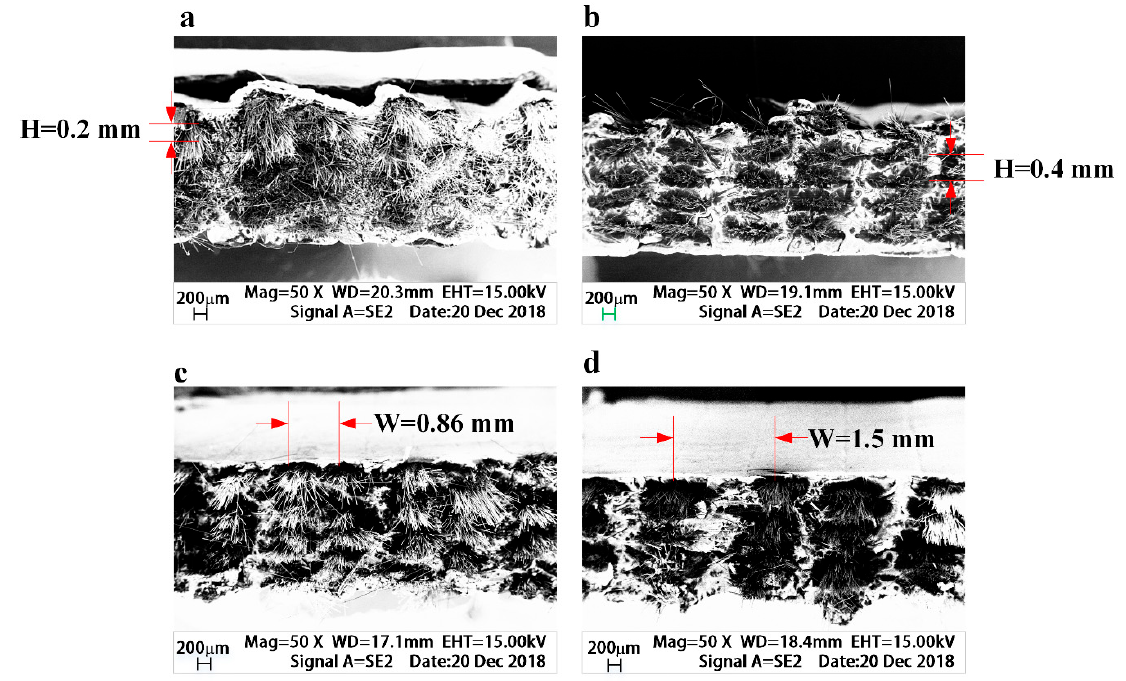
Figure 13. Fracture cross section of tensile specimens with different relative fiber content. ( a )H = 0.2 mm; ( b ) H = 0.4 mm; ( c ) W = 0.86 mm; ( d ) W = 1.5 mm.